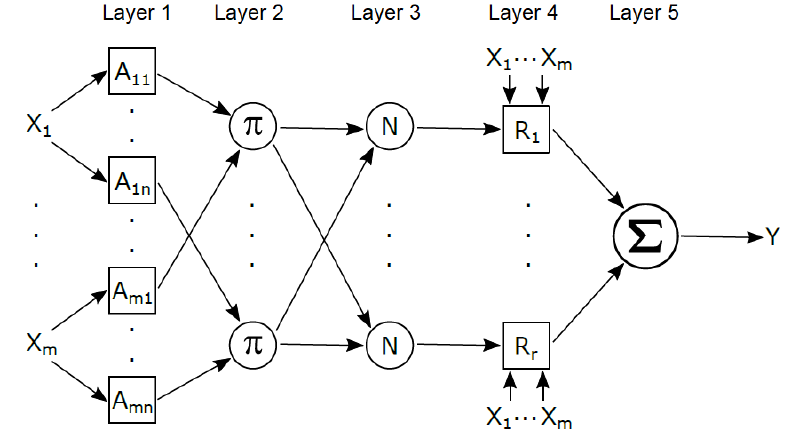
Figure 5. ANFIS network framework